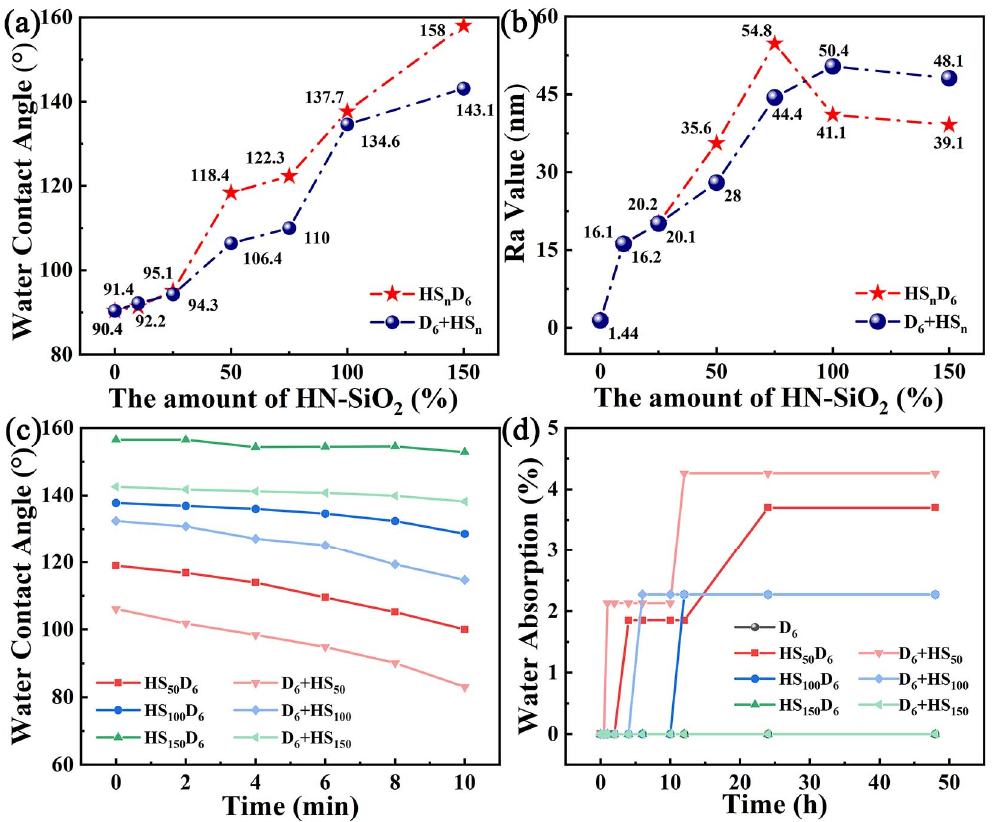
Figure 5. ( a ) Water contact angle and ( b ) Ra value of CNF/HN-SiO 2 films. ( c ) Change of WCA and ( d ) hygroscopicity of HS n D 6 -film and D 6 + HS n -film with different time. The present reported hydrophobic materials by mixing hydrophobic SiO 2 and cellu- lose-based materials in recent years are listed in Table 2. Benefitting from the cellulose- based mechanochemical modification dispersion method, the HS 150 D 6 coating exhibits high super-hydrophobicity with a water contact angle over 158°. Table 2. Comparison of hydrophobic SiO 2 and cellulose-based composite in recent literatures. Year